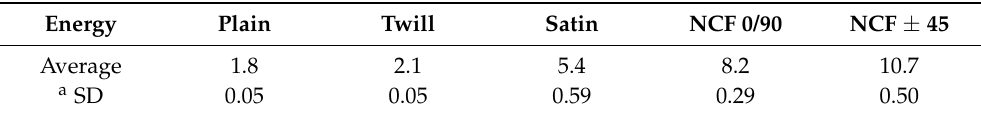
Table 4. Deformation energy for draping each fabric (J = N · m). Energy Plain Twill Satin NCF 0/90 NCF ± 45 Average 1.8 2.1 5.4 8.2 10.7 a SD 0.05 0.05 0.59 0.29